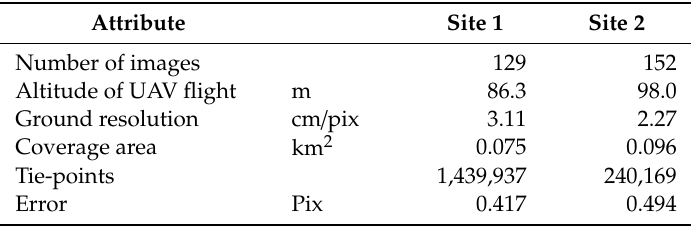
Table 1. Settings used to generate 3D point cloud